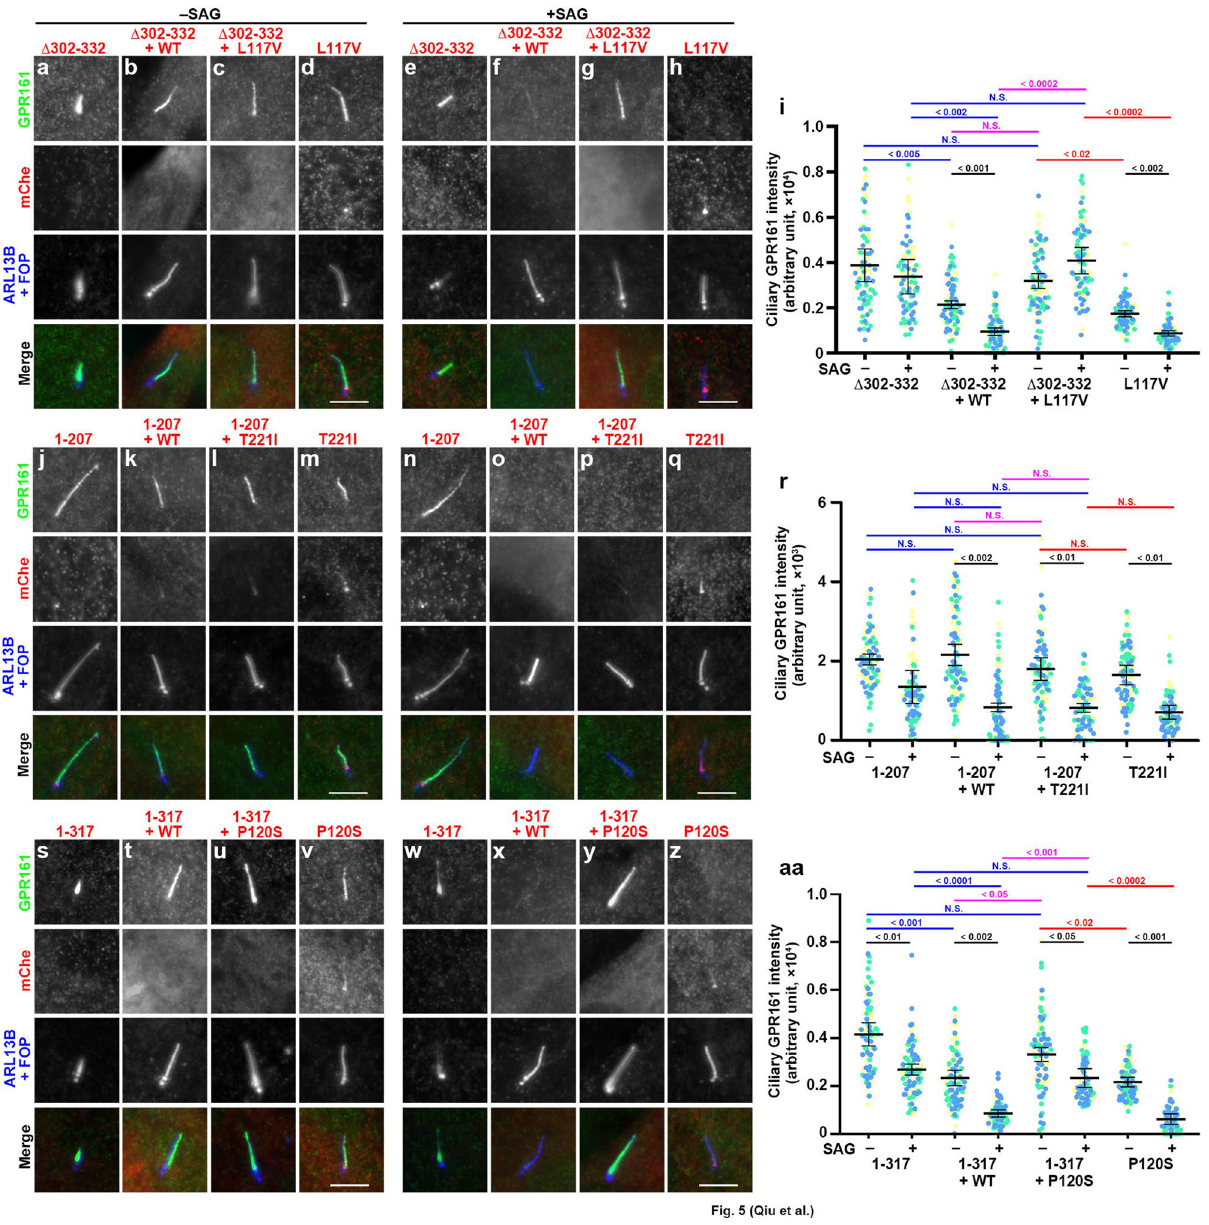
Figure 5. Specific combinations of DYNC2LI1 variants are unable to rescue defects in the induced exit of GPR161 from cilia in DYNC2LI1 -KO cells. ( a – h , j – q , u – z ) DYNC2LI1 -KO cells expressing the indicated mChe- fused DYNC2LI1 construct or the indicated combinations of mChe-fused DYNC2LI1 constructs were serum- starved for 24 h to induce ciliogenesis, cultured in the absence ( a – d , j – m , s – v ; –SAG) or presence ( e – h , n – q , w – z ; + SAG) of SAG for a further 24 h, and immunostained with antibodies against GPR161 and ARL13B + FOP. Scale bars, 5 µm. (i, r, aa) Relative ciliary staining intensities of GPR161 in the experiments shown in a–h, j–q, and s–z, respectively, were estimated and expressed as scatter plots, and analyzed as described in the legend to Fig.